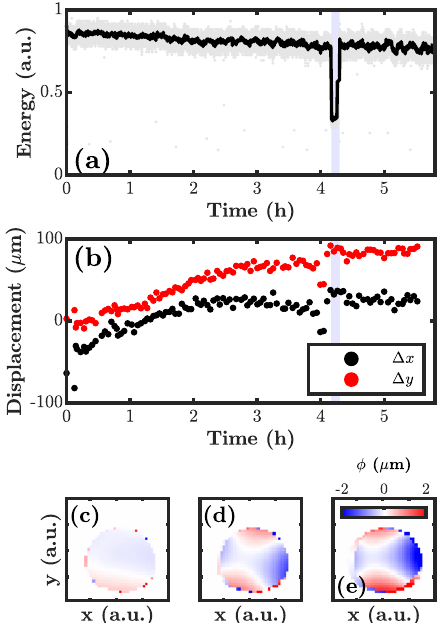
Figure 1. Evolution of the laser parameters . (a) Evolution of the laser energy. (b) Drift of the far field. (c-e) Wavefront of the laser beam after operating the laser for a period of (c) 45min, (d) 1 . 5h, and (e) 5 .